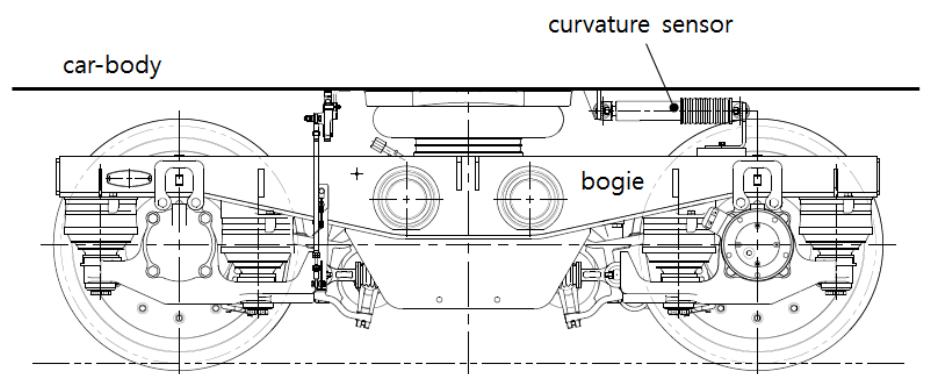
Figure 10. Structure of the curvature sensor.